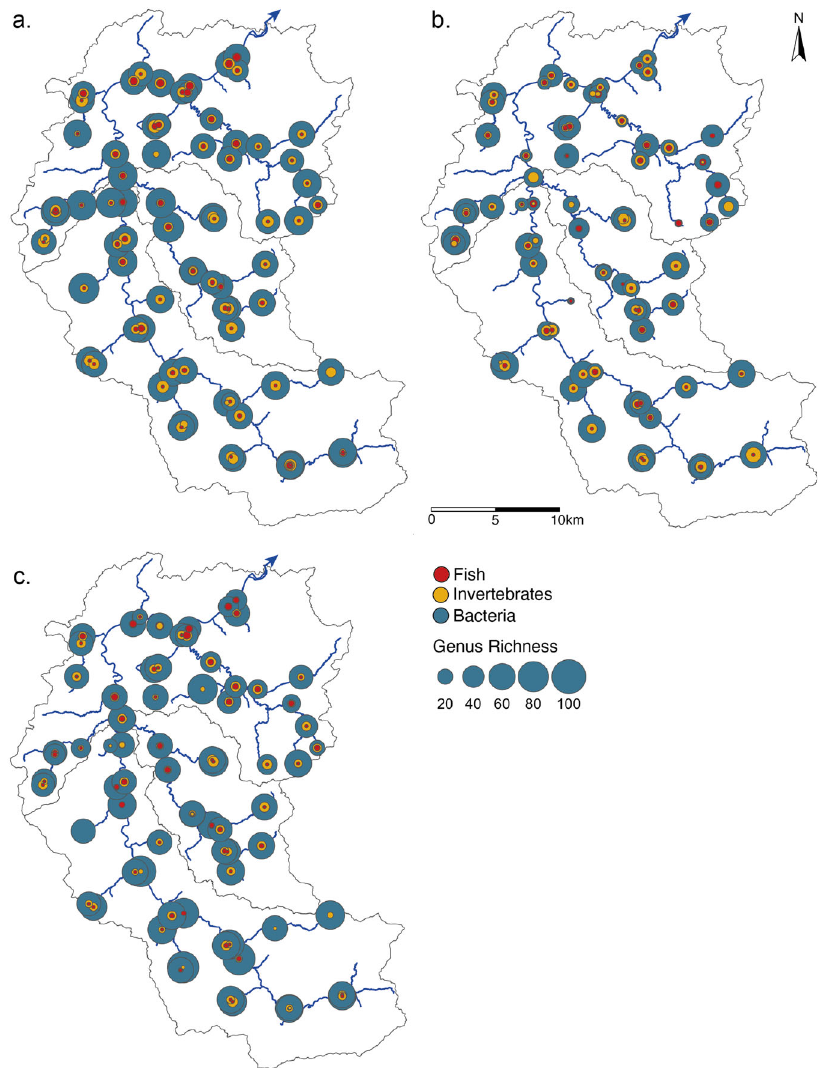
Fig. 2 Genus α -diversity of bacteria, invertebrates and fi sh collected from eDNA samples in the Thur catchment. Maps show the α -diversity of each taxonomic group in ( a ) spring, ( b ) summer and ( c ) autumn. The circles are scaled proportionate to the α -diversity of each group. Grey lines give the sub- catchments Glatt, Necker, and Thur, respectively and the blue arrow shows the direction of fl